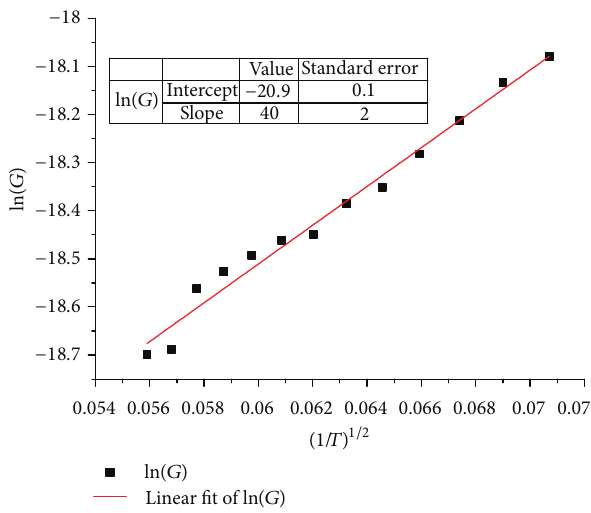
Figure 4: Plot of the log of the conductance versus the inverse square root of the temperature used for the fit demonstrating percolation